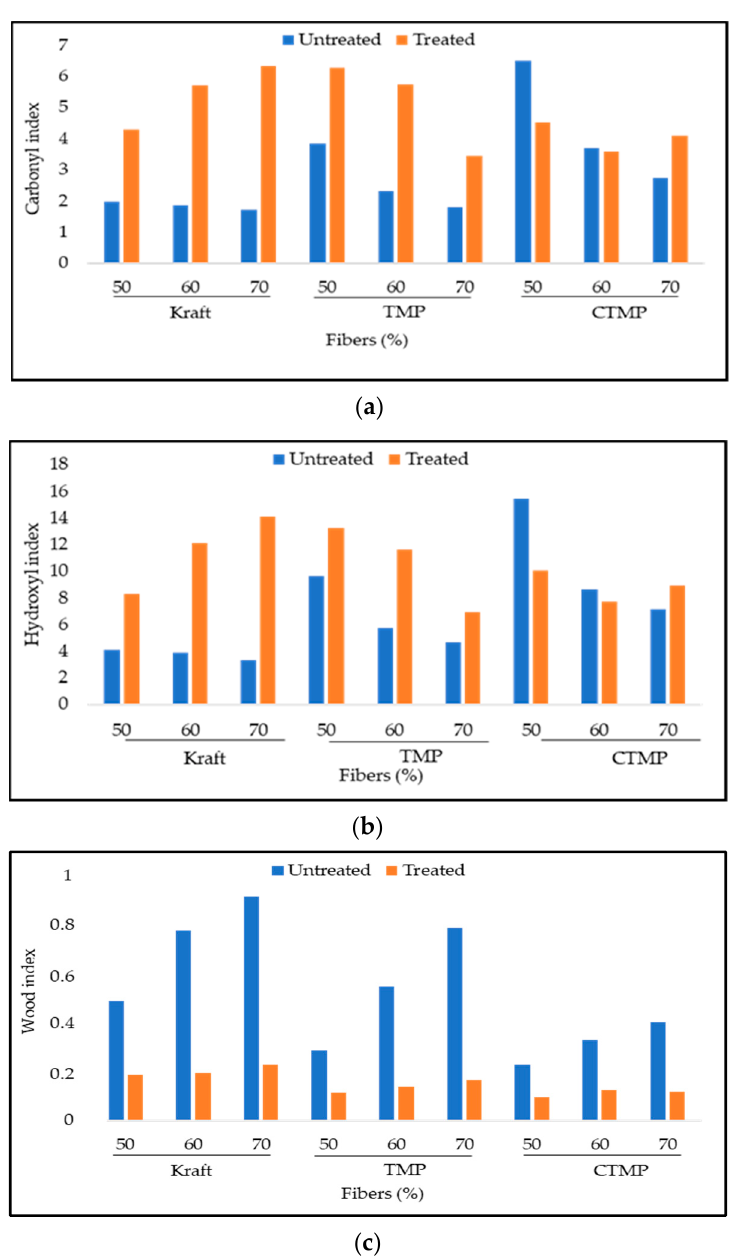
Figure 1. Effects of the chromic treatment on the surface chemistry of polypropylene-based compo- sites before and after chromic treatment: ( a ) carbonyl index, ( b ) hydroxyl index, and ( c ) wood index.